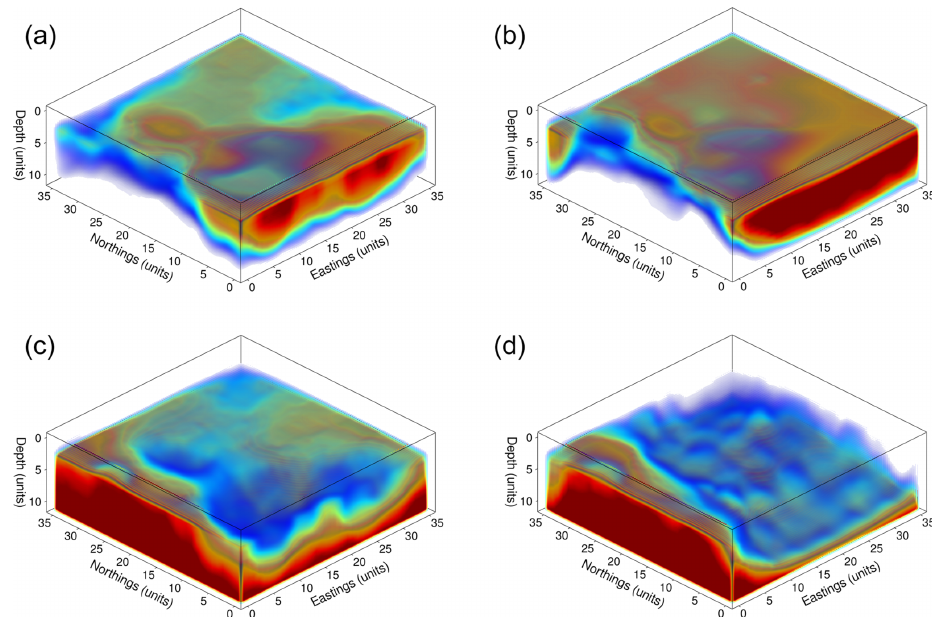
Figure 7. Volume renderings of the posterior mean for runs B (a, c) and D (b, d) , demonstrating the change in inference at depth. (a, b) Probability of occupancy for layer 5 (granite intrusion). (c, d) Probability of occupancy for layer 6 (basement). Red volumes indicate high probability, and blue volumes indicate low probability; zero-probability regions have been rendered transparent to make the shape of the region more readily